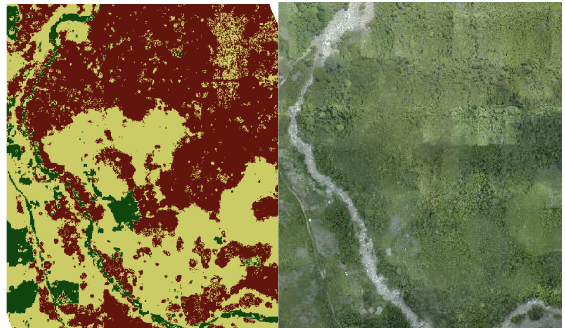
Figure 20. High probability of shallow relict landslide and orthophoto of the area Rotational rotational active, except at the middle of transport zone, which